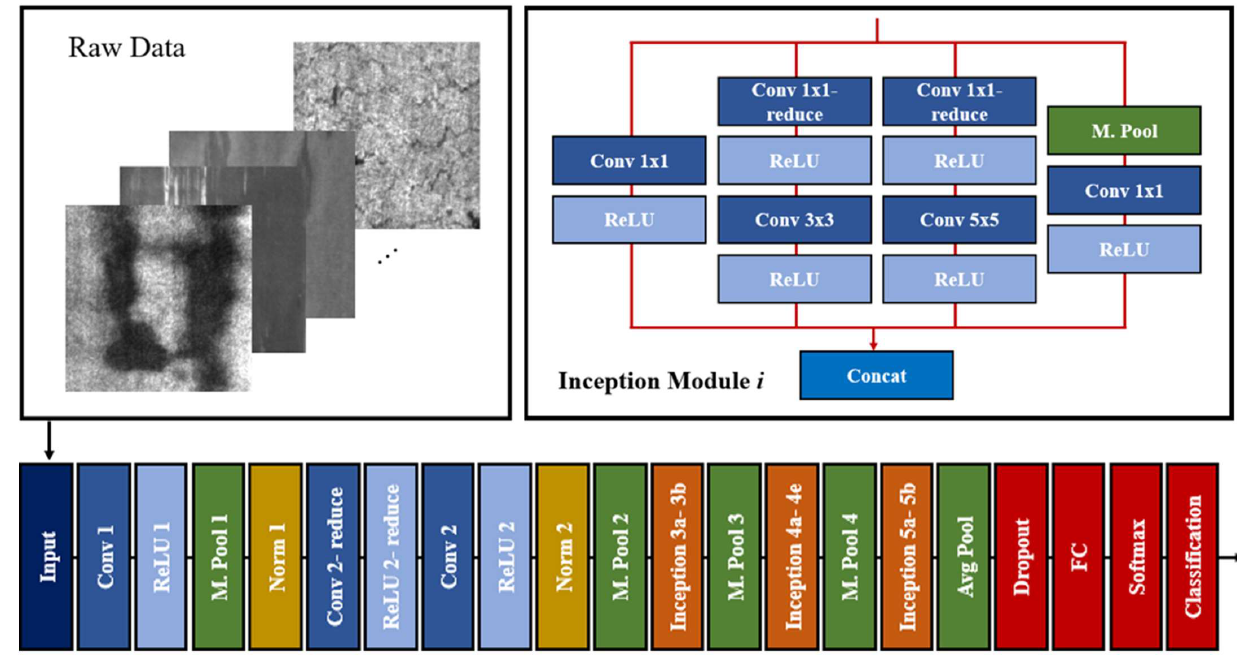
Figure 2. The architecture of the pre-trained GoogLeNet. Conv represents the convolutional layer, M. Pool represents the max pooling layer, Norm represents the local response normalization, and Avg Pool represents the average pooling.